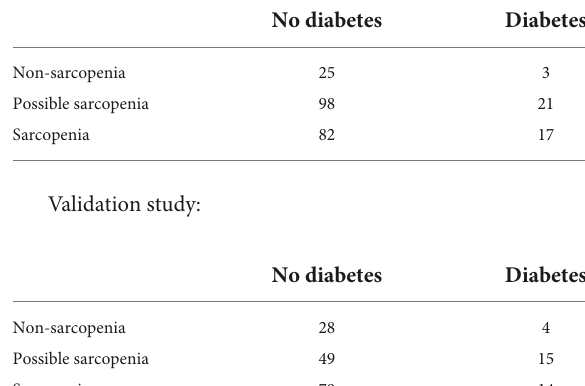
additional examination of their medication